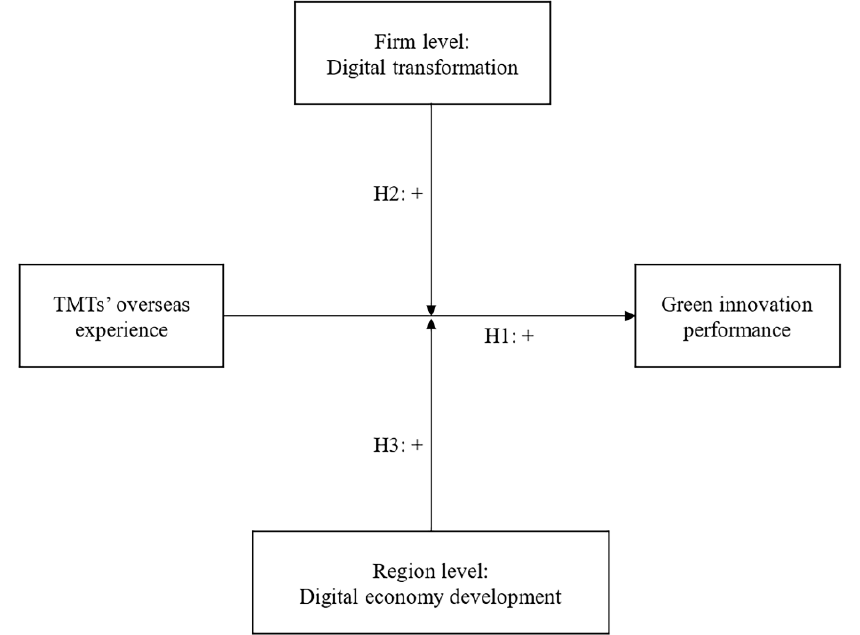
Figure 1. Conceptual framework.